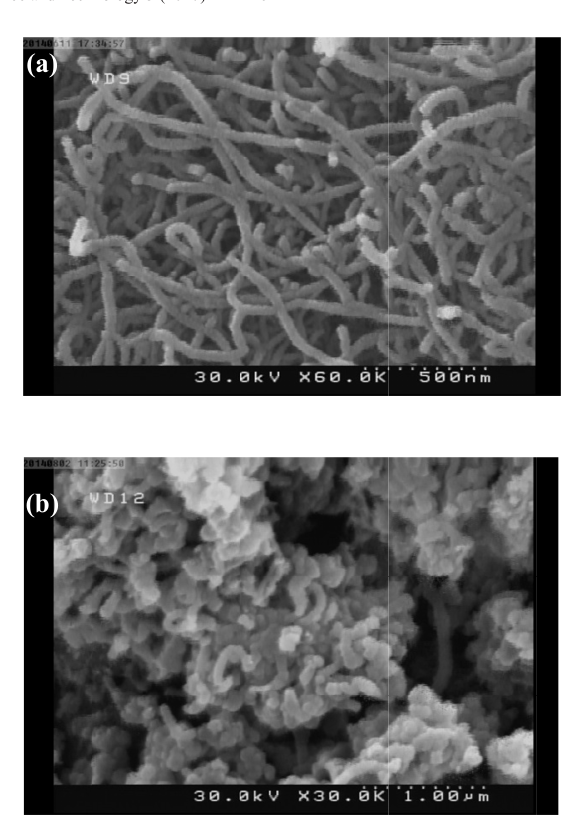
Fig. 2. Field emission Scanning electron microscope (FESEM) images of (a) CNT and (b) CNT@SiO 2